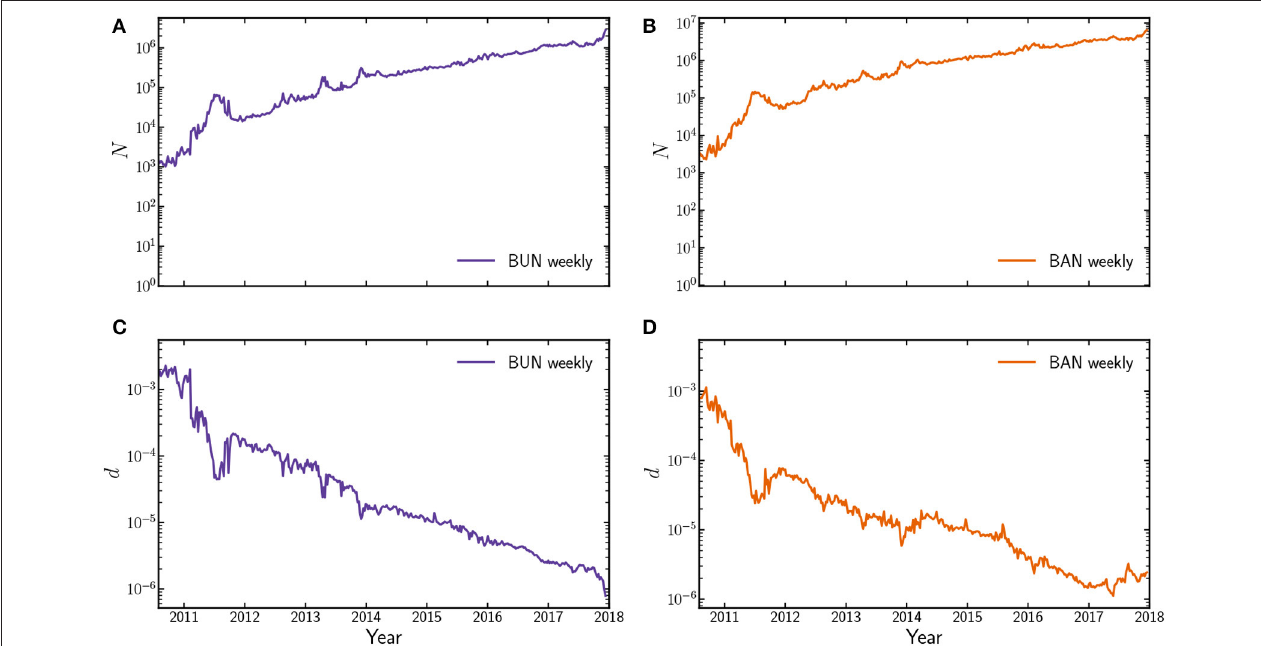
FIGURE 1 | Evolution of basic statistics, i.e., the number of nodes (A,B) and the link density (C,D) for two Bitcoin network representations, i.e., the BAN (A,C) and the BUN (B,D) at the weekly time scale, from July 2010 to 18th December 2017 (i.e., for networks with at least 200 nodes). Although the network size increases, it becomes sparser (irrespectively from the considered representation). Similar results are observed for the BAN and the BUN at the daily time scale. See also Bovet et al. [